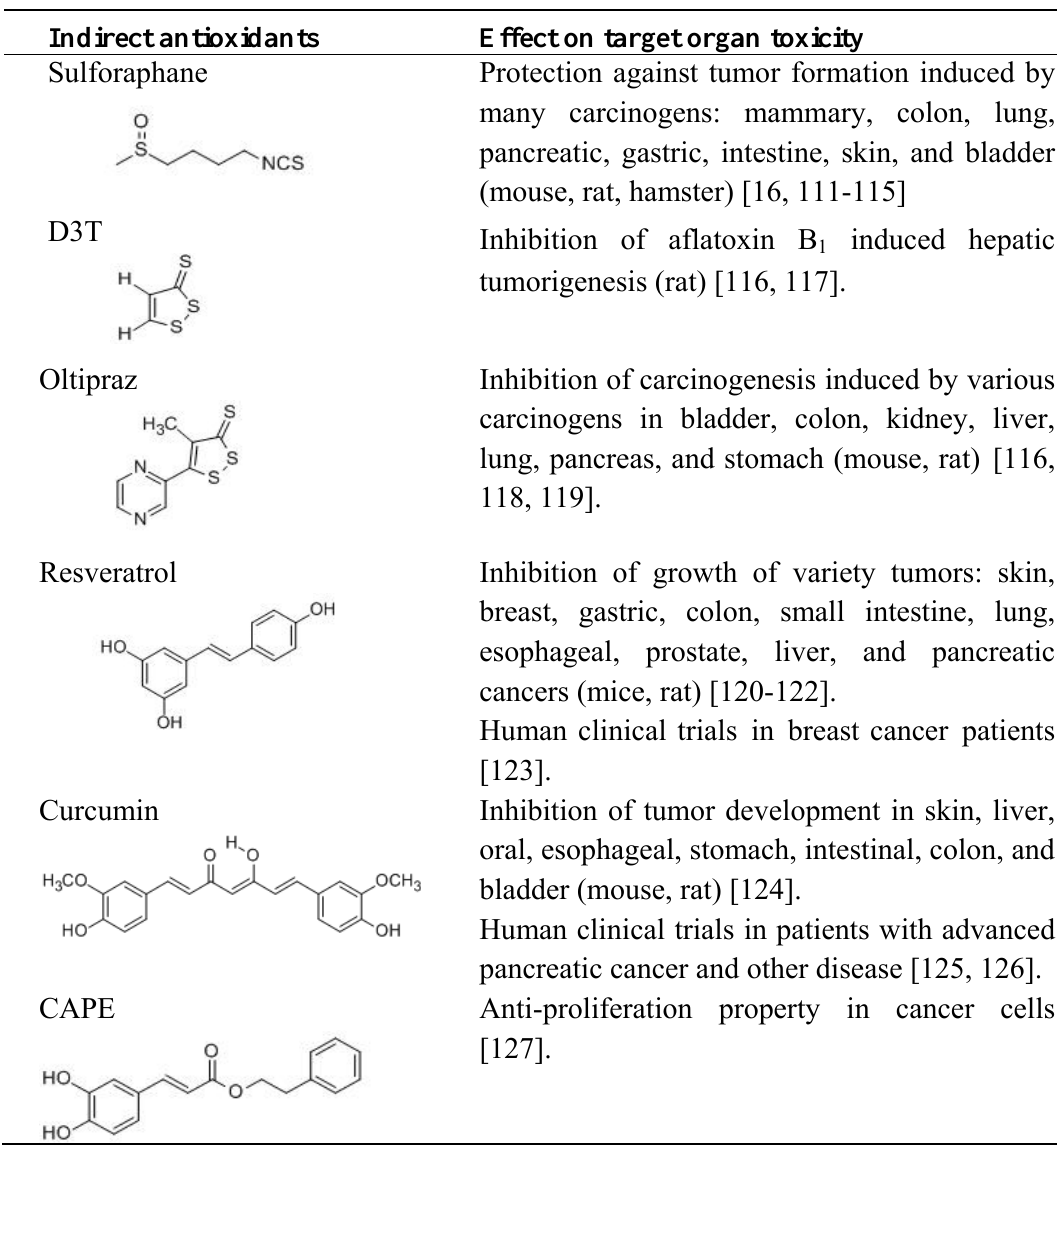
Table 2. Indirect antioxidants and their effects on chemical